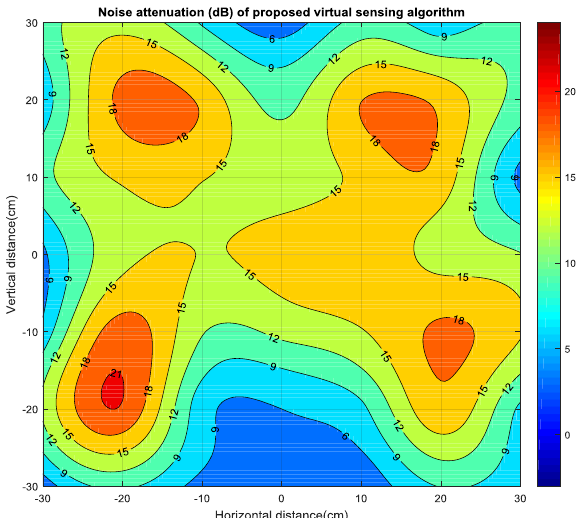
Figure 11. The quiet zone generated by the proposed algorithm with physical microphones located at (25, 25), (−25, 25), (−25, −25) and (25, −25). Electronics 2017 , 6 , 76